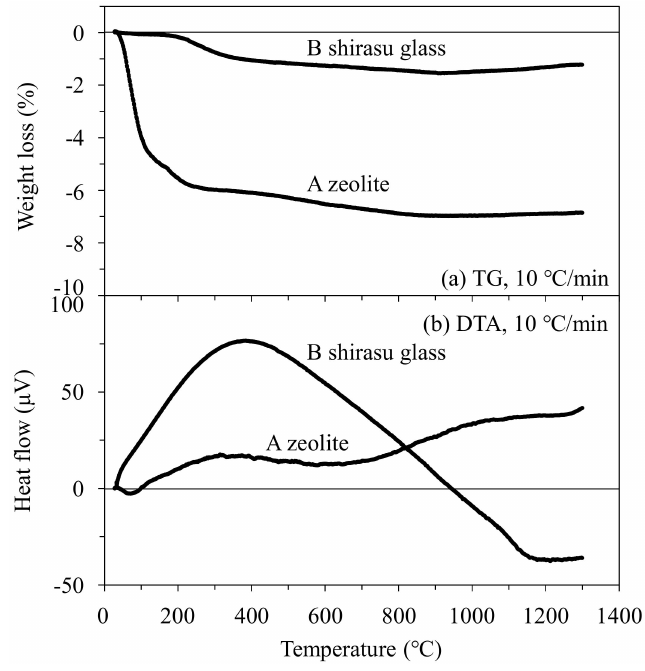
Figure 6. Thermogravimetric/differential thermal analysis (TG/DTA) curves for (A) mordenite zeolite and (B) shirasu